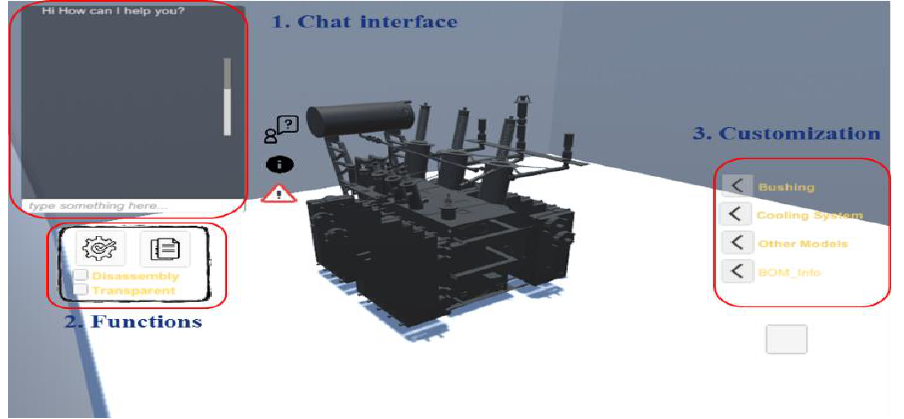
Figure 12. Interfaces of the consultation chatbot system.